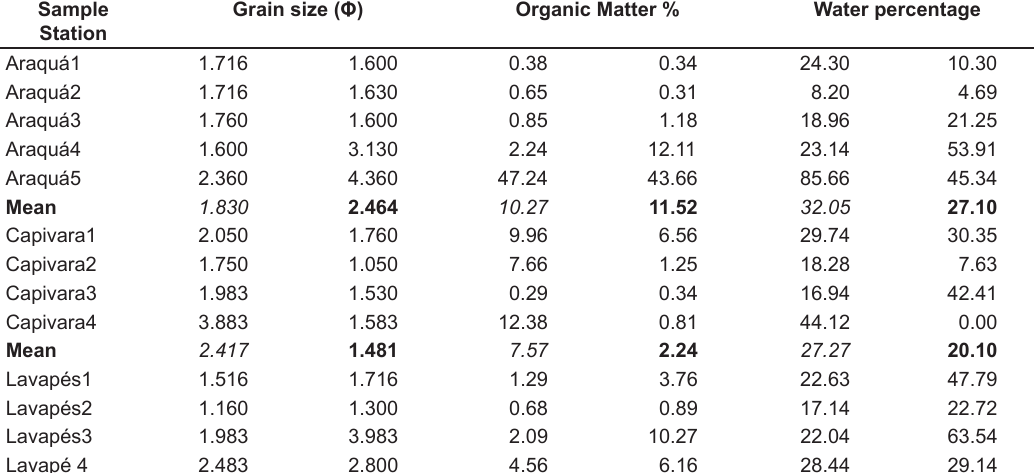
Table 5. Grain size, organic matter and water percentage in the sediment samples of Araquá, Capivara, Lavapés and Pardo Rivers during the rainy and dry (in bold) periods of